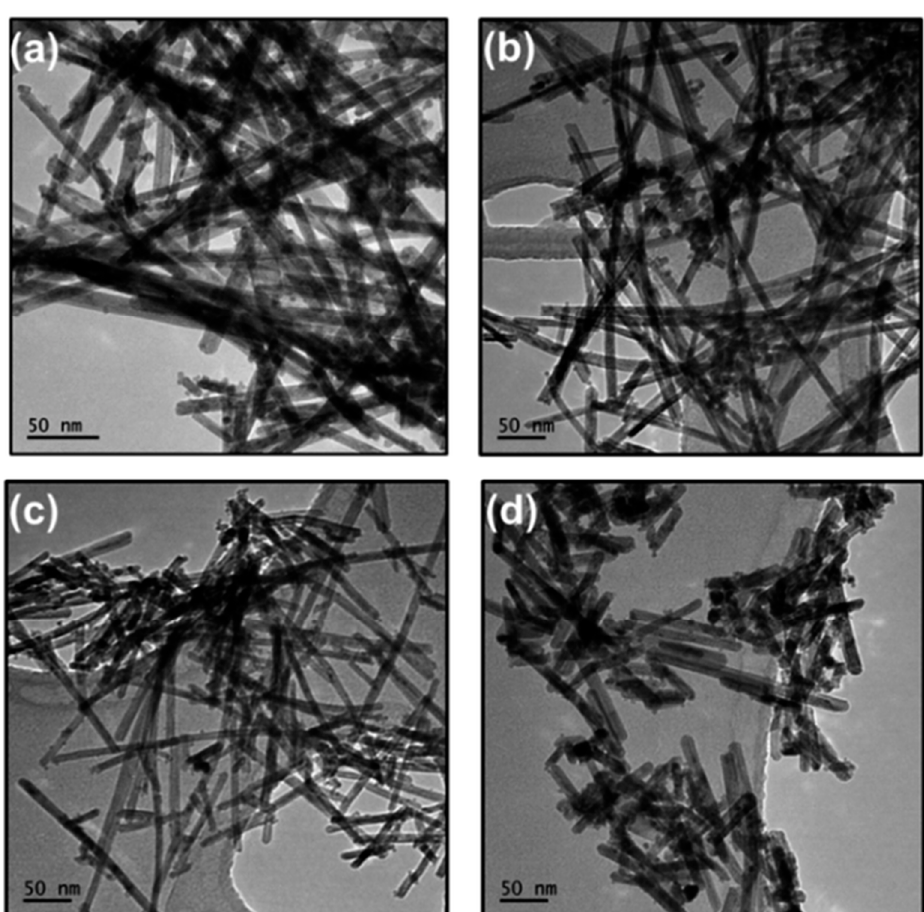
Figure 6. Nanorods of ceria materials prepared by Jampaiah: TEM images of ( a ) CeO 2 , ( b ) Ce 0 . 9 Mn 0 . 1 O 2 − δ (Mn–CeO 2 ), ( c ) Ce 0 . 9 Co 0 . 1 O 2 − δ (Co–CeO 2 ) and ( d ) Ce 0 . 9 Ni 0 . 1 O 2 − δ (Ni–CeO 2 ) [65].